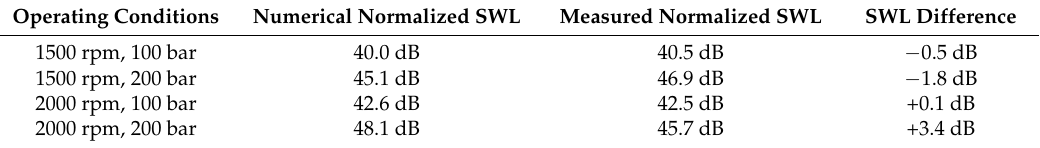
Table 5. Comparison of measured SWLs with numerical SWLs for four different operating